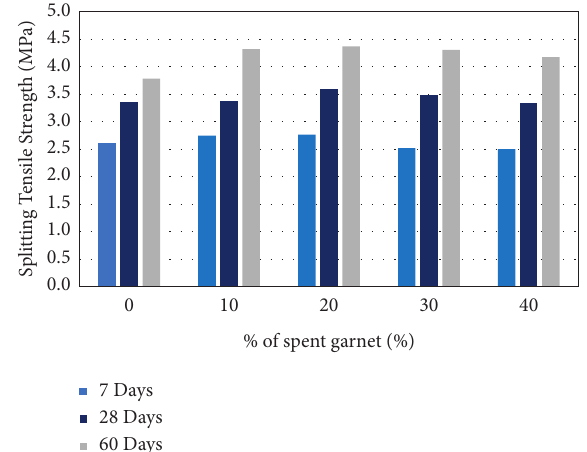
Figure 13: Splitting tensile strength of POC LWAC containing spent